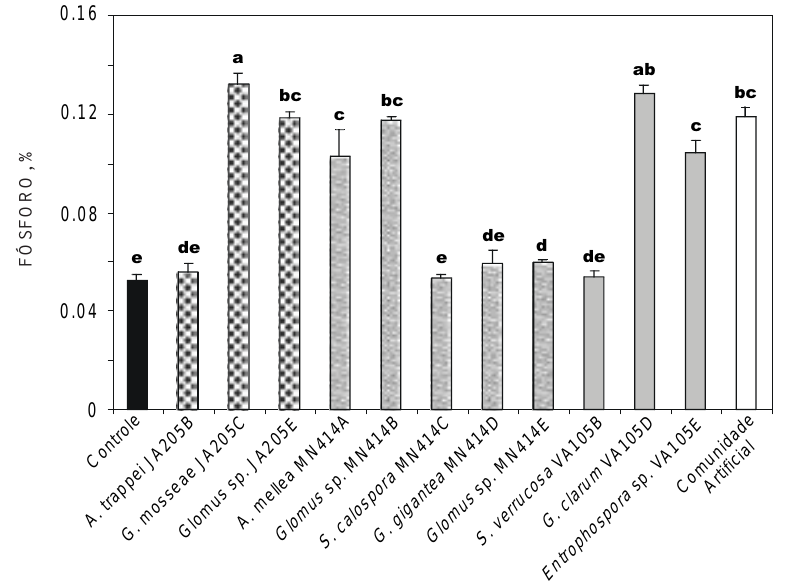
Figura 2. Conteúdo de fósforo na parte aérea de plantas de soja inoculadas com isolados de FMA originados de três comunidades distintas. Colunas representam a média de cinco repetições e barras representam o